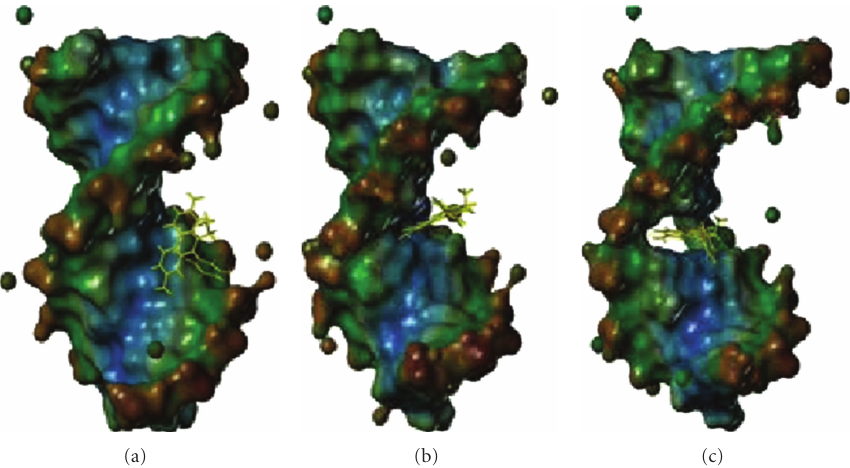
Figure 1: Three snapshots along the dynamics simulation movie, found at http://www.youtube.com/watch?v = ItSyPPH4T8g. ( a ) Initial placement of ethidium ligand with respect to the dsDNA decamer, ( b ) image captured as ethidium rotated and the base pairs began to rupture their directed hydrogen bonds, ( c ) the final, intercalated state. The movie and these graphics were produced from the original dynamics data by Dr. Michael